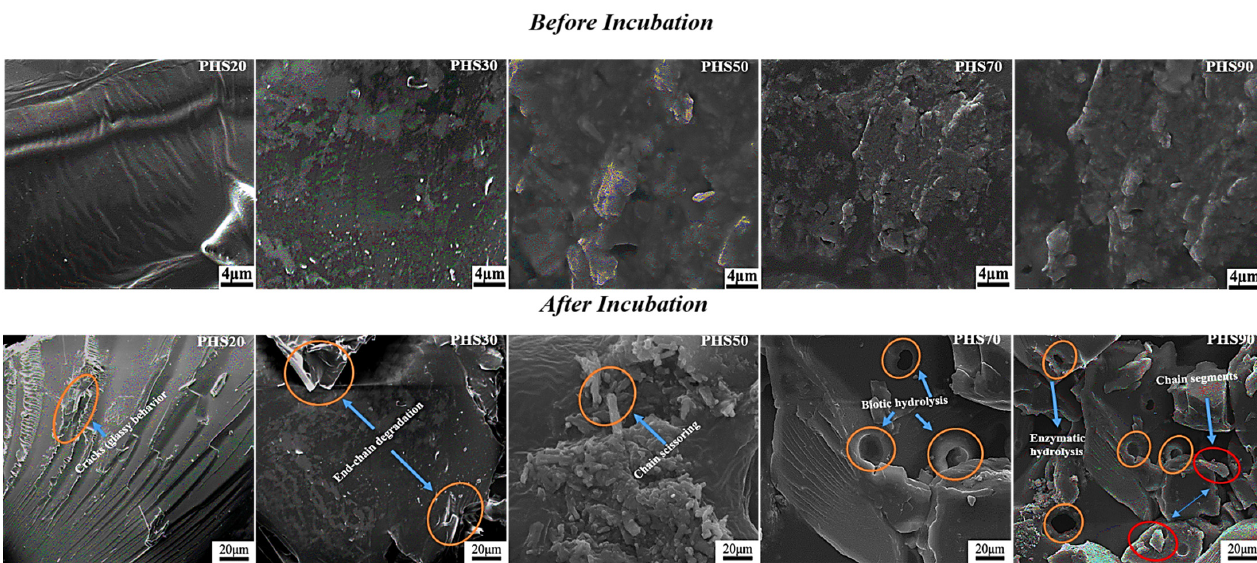
Figure 9. Residual weight versus. incubation time for PHS(20–90) under different conditions: ( a ) pH = 7.4, ( b ) pH = 2, ( c ) enzymatic degradation with Pseudomonas fluorescens lipases (at neutral pH).